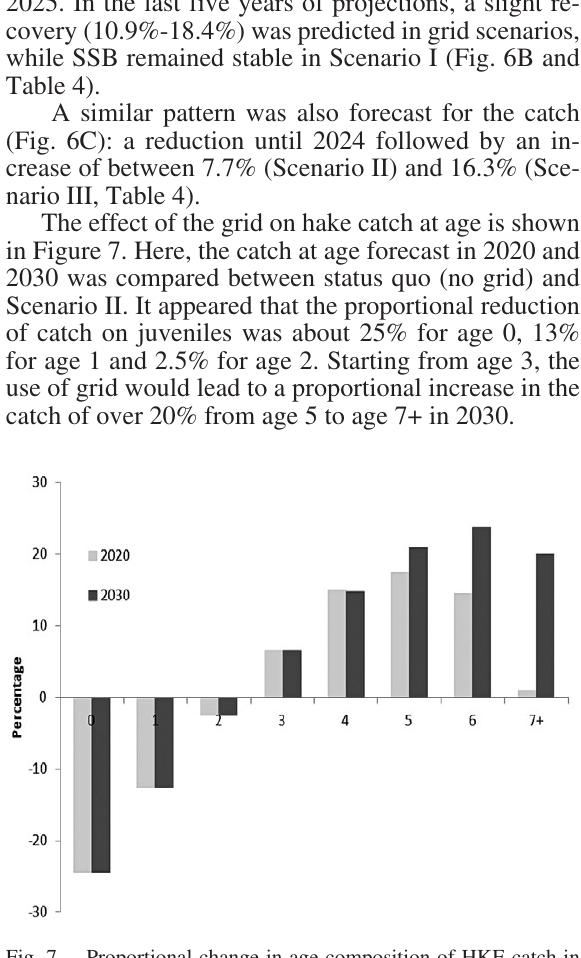
Fig. 7. – Proportional change in age composition of HKE catch in 2020 and 2030 in Scenario II (trawl net with grid and recruitment as in the status quo) when compared with status quo Scenario II (traditional trawl